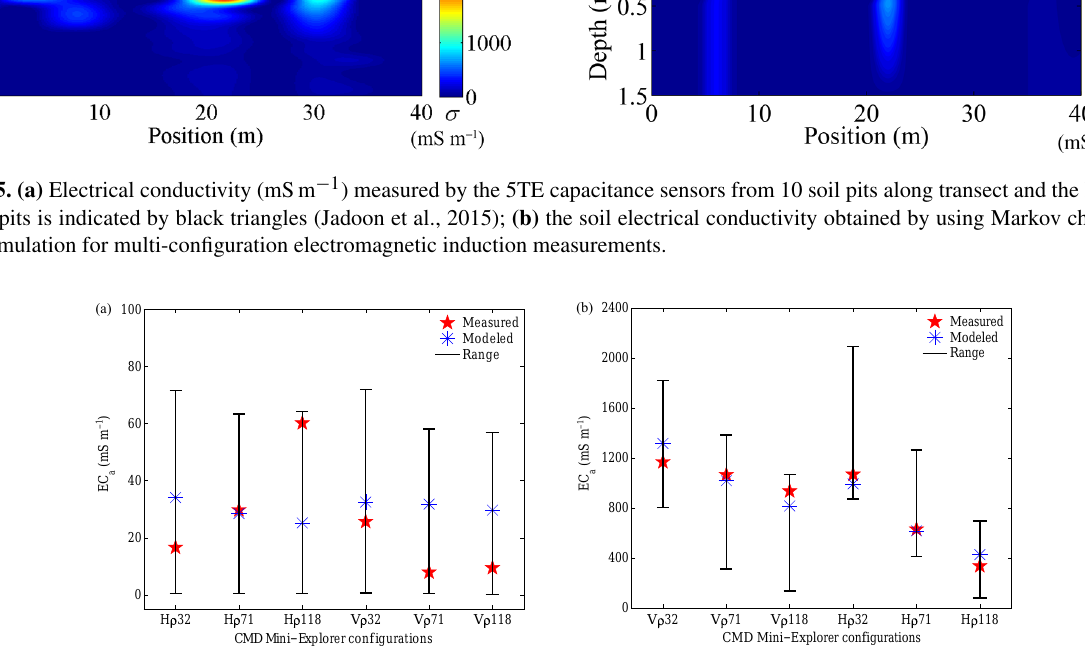
Figure 6. Measured six different configuration of CMD Mini-Explorer (red star), estimated (modeled) earth electrical conductivity (blue asterisk) and the range of EC a simulated by MCMC for (a) non-saline soil at pit 4 and (b) saline soil at pit 9